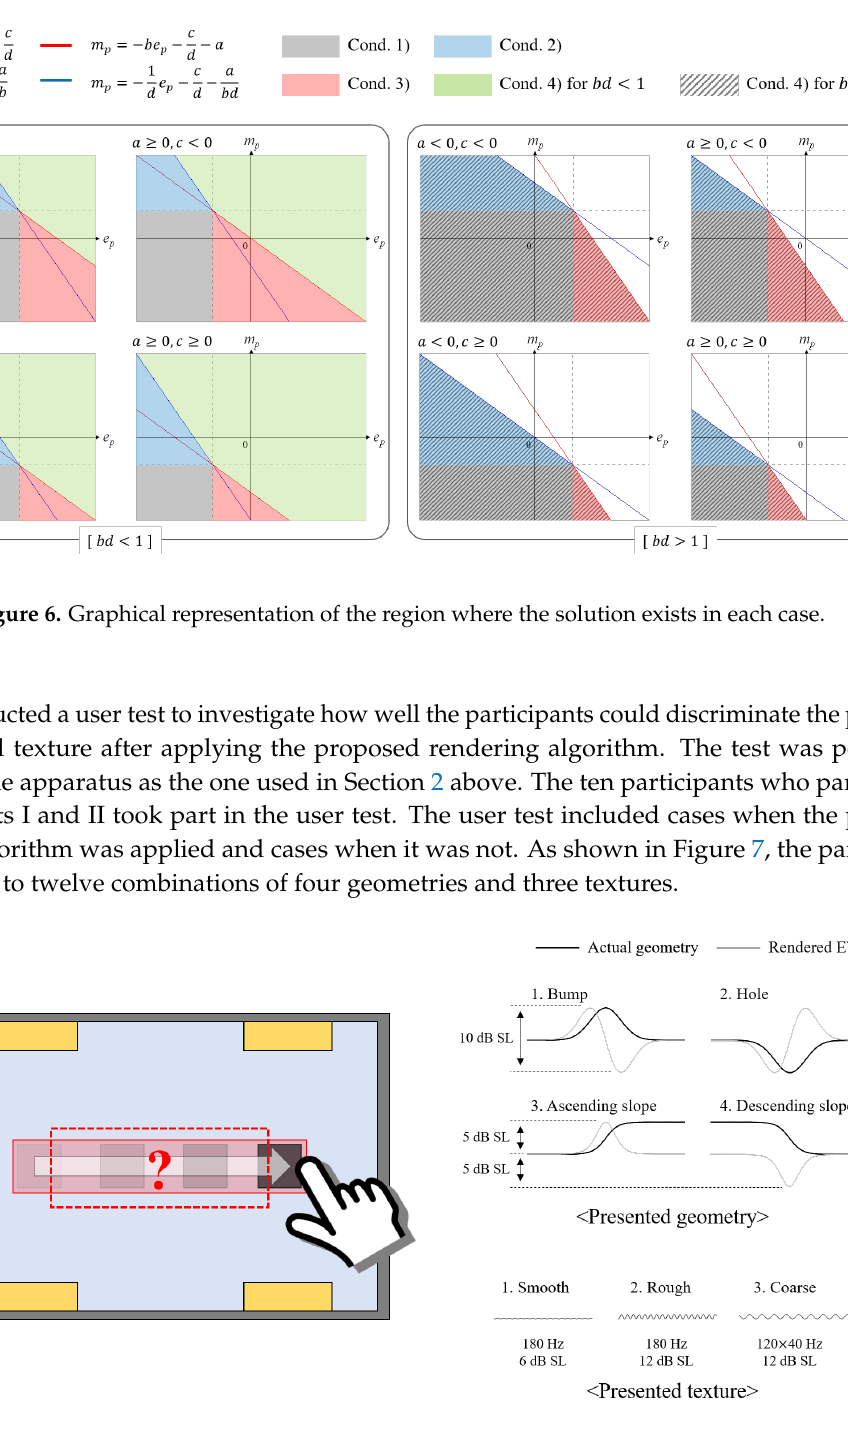
Figure 7. User test: experimental procedure and stimulus